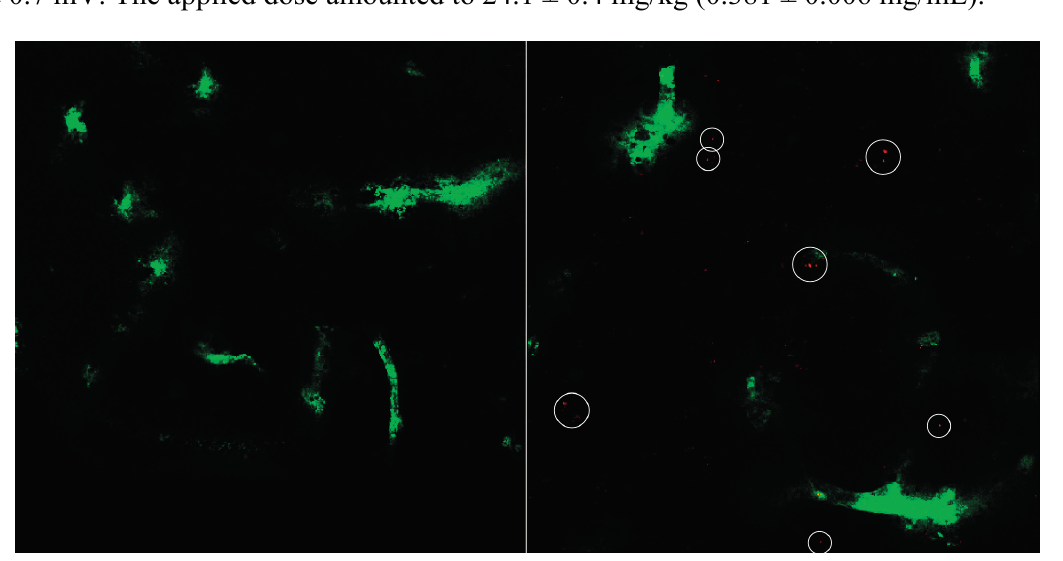
Figure 8. Exemplary image of rat brain cryosection after 24 h of cBSA-liposome incubation ( right ) with control ( left ). Capillaries have been stained with FITC-BSA (green). Liposomal rhodamine B